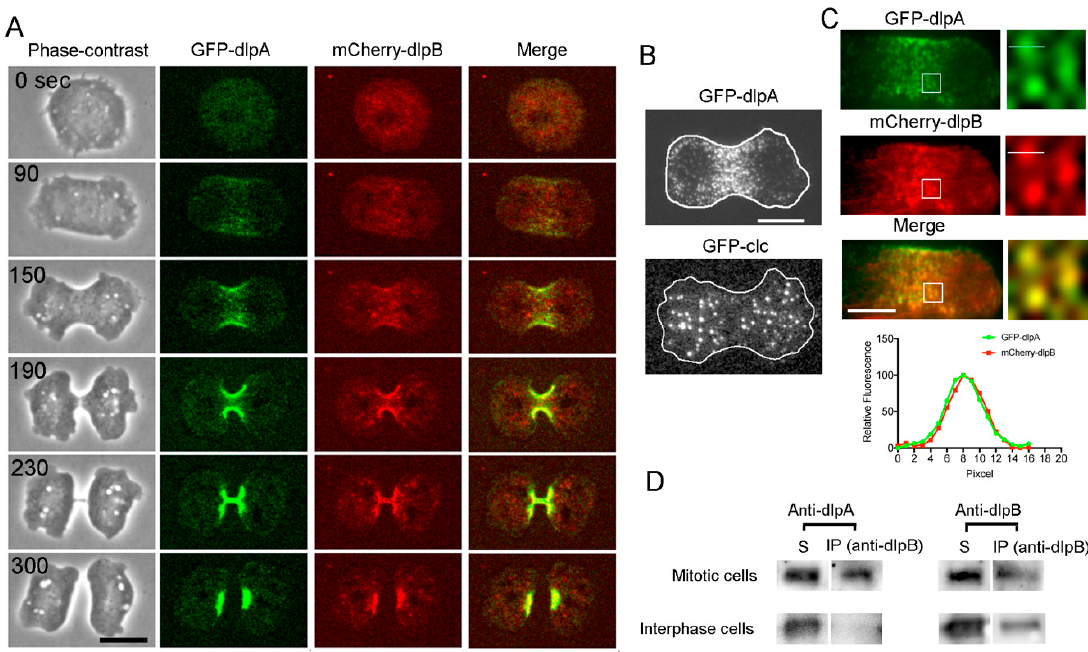
Figure 3. DlpA and dlpB colocalize at the cleavage furrow. ( A ) A typical time course of fluorescence images of a dividing cell simultaneously expressing GFP-dlpA (green) and mCherry-dlpB (red). The merged images (Merge) show that both proteins accumulated at the same place at the same timing. These observations were confirmed in 18 dividing cells. ( B ) Typical total internal reflection fluorescence (TIRF) images of GFP-dlpA and GFP-clathrin light chain (GFP-clc). The outlines of the cells are indicated in white. ( C ) Typical TIRF images of GFP-dlpA and mCherry-dlpB in the same dividing cell. The right panels show enlarged images of the boxes in the left panels. The graph shows the fluorescence intensity profile on the white line across the single dot. ( D ) Co-immunoprecipitation assay. After anti-dlpB antibodies-bound magnetic beads were mixed with the lysate of partially synchronized wild-type cells, and the immunoprecipitated proteins (IP) and the supernatant proteins (S) were detected by western blot using anti-dlpA and anti-dlpB antibodies, respectively. The amount of dlpA in the IP fraction of synchronized (mitotic) cells was 58 ± 8% of that in supernatant ( n = 3), but only slight amount of dlpA was detected in non-synchronized (interphase) cell lysate. Bars, 10 µm.